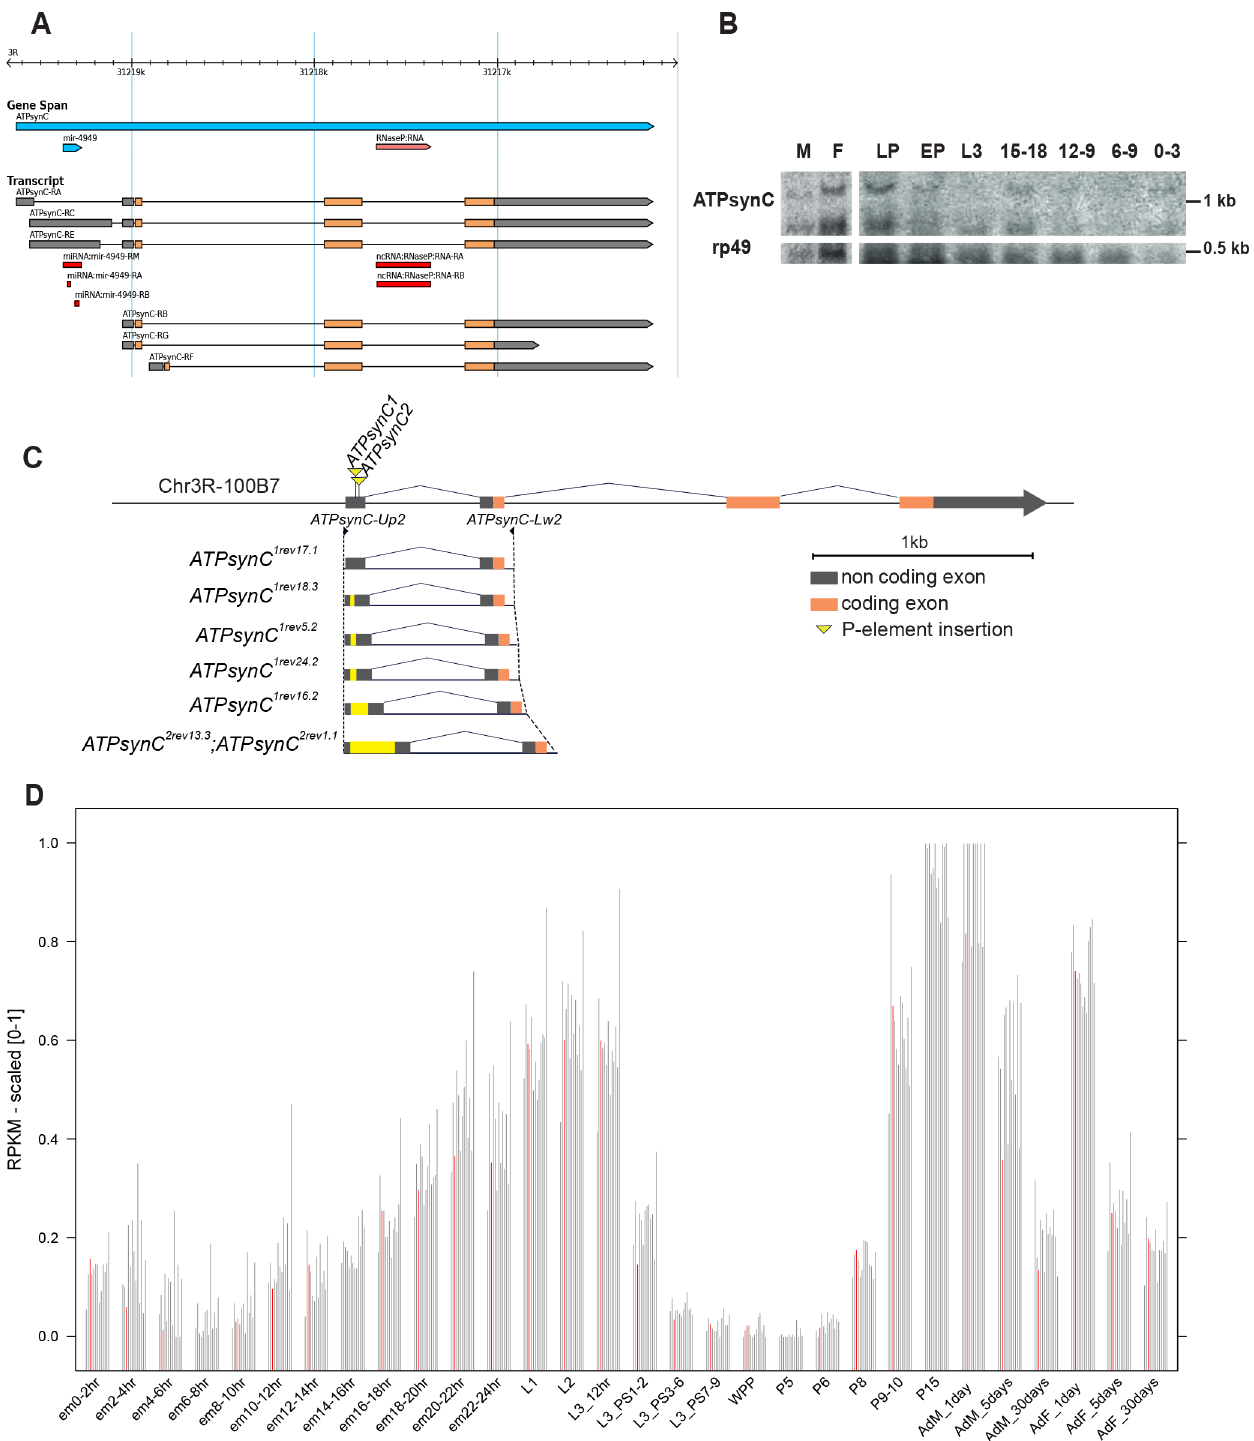
Fig 2. The Drosophila melanogaster ATPsynC gene. (A) FlyBase annotation of ATPsynC (FBgn0039830). Untranslated regions are depicted in grey; CDSs are depicted in light orange. Non-coding RNAs also transcribed from the ATPsynC locus are shown in red. (B) Northern blot analysis of ATPsynC expression during Drosophila development, compared to the housekeeping gene rp49 .M = adult male (mixed age); F = adult female (mixed age); LP = late pupal stage; EP = early pupal stage; L3 = third instar larval stage; 0–3, 6–9, 12–9 and 15–18 correspond to hours of embryonic development at 25˚C. (C) Schematic representation of ATPsynC P-element insertions and the alleles derived after transposon remobilization. (D) Expression analysis of the 13 nuclear genes